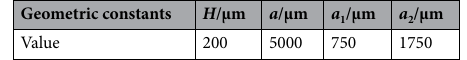
Geometric constants